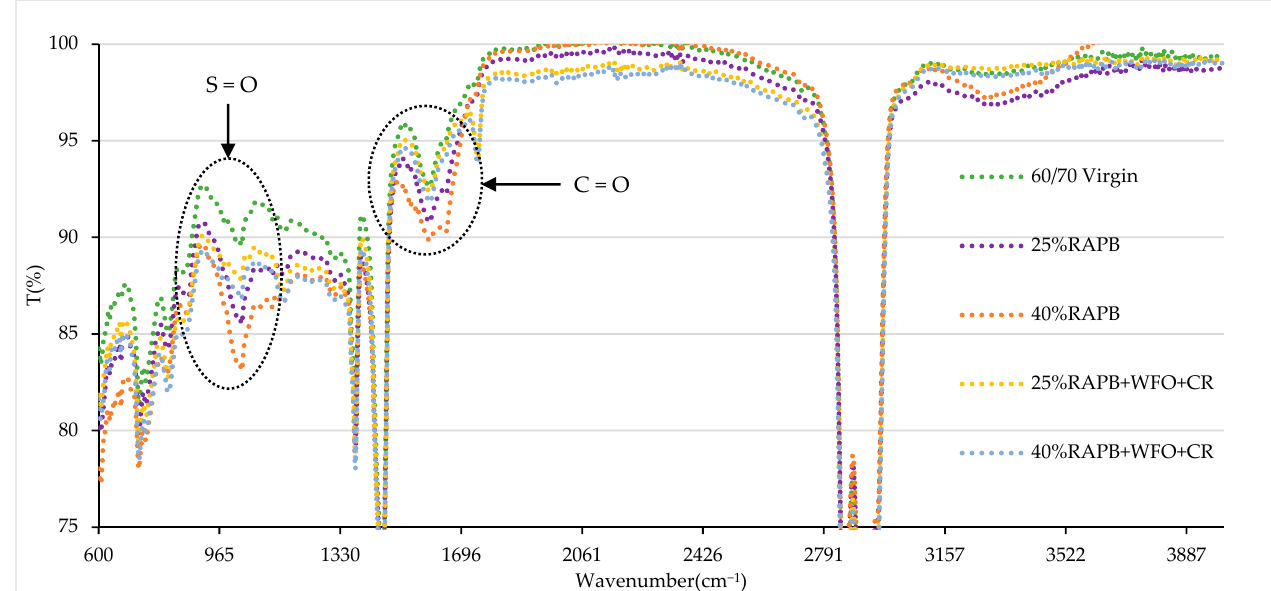
Figure 11. Results of FTIR spectra of the virgin, RAP, and recycled binders under short-term aging conditions.